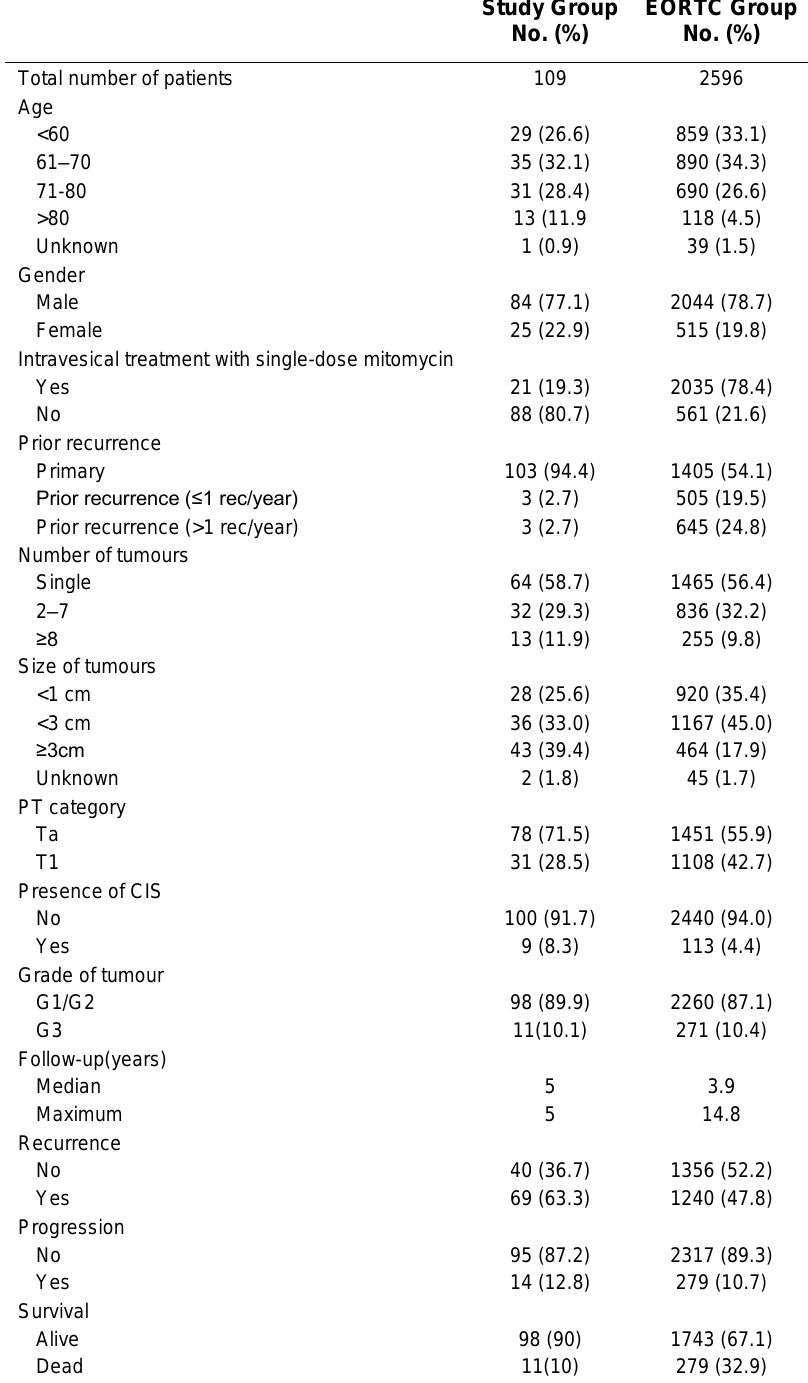
Patient Characteristics in Our Study Group and the EORTC